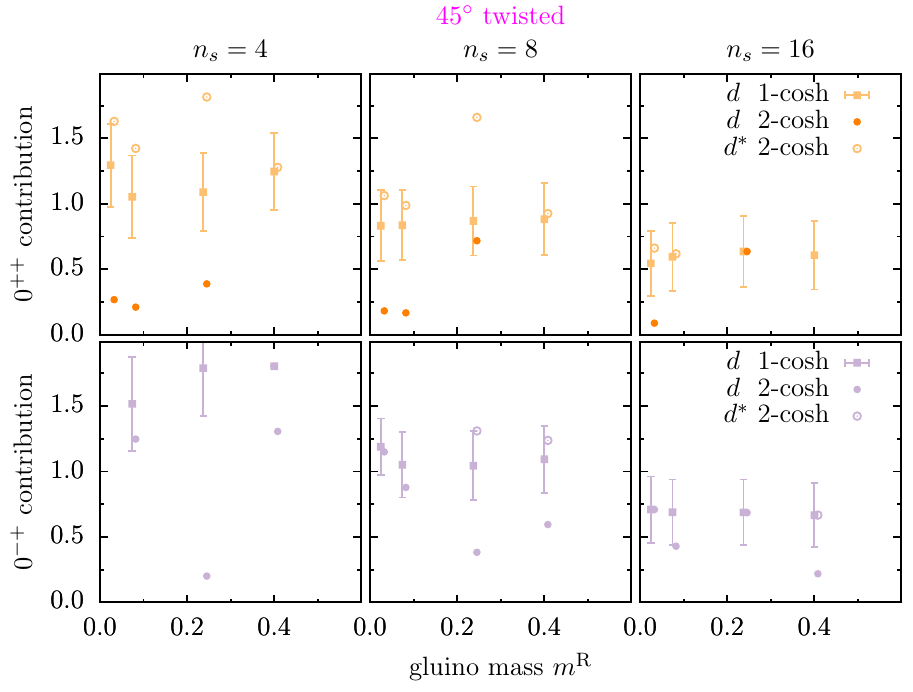
Figure 13 . Top/Bottom: scalar/pseudoscalar glueball on the 16 3 × 32 lattice with twist angle α = 45 ◦ as a function of the gluino mass m R . Data points are slightly displaced for better visibility. In the different panels, n s = { 4 , 8 , 16 } steps of stout smearing are applied to smooth the data. Both 1-cosh-fit and 2-cosh-fit results are shown for comparison. Two resp. four time slices are ignored in the correlator fit at the lattice boundary resp. in the center. For better clarity some (over-estimated) error bars are not